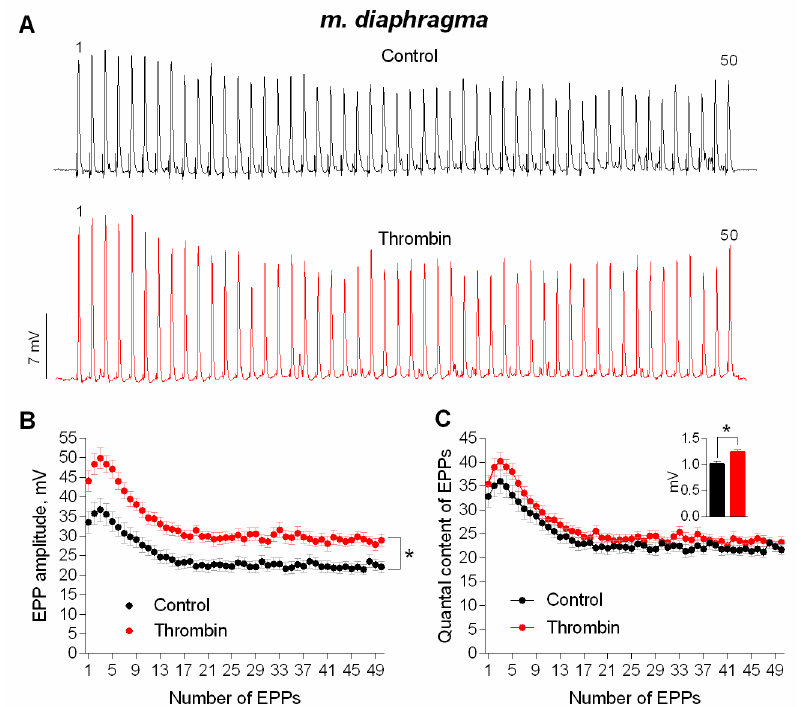
Figure 2. Thrombin-induced upregulation of evoked neuromuscular transmission during short (1 s) high-frequency (50 Hz) trains in mouse diaphragm. ( A ) Representative recordings of EPPs in control (above) and upon application of thrombin (1 nM) (below). ( B ) Changes in the EPP amplitude in control ( n = 17) and upon application of thrombin ( n = 17). ( C ) Quantal content of EPPs in control and upon application of thrombin. Inset shows MEPP amplitudes. Histograms, symbols and error bars represent the mean ± SEM. * p < 0.05 compared to control .